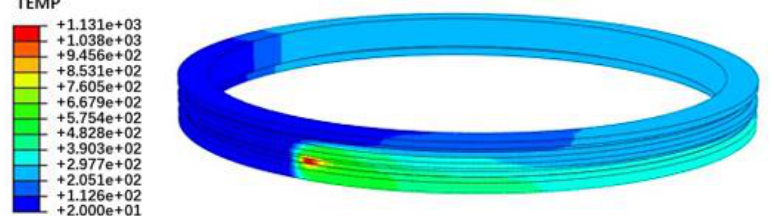
Figure 3. Distribution of temperature field of the raceway.